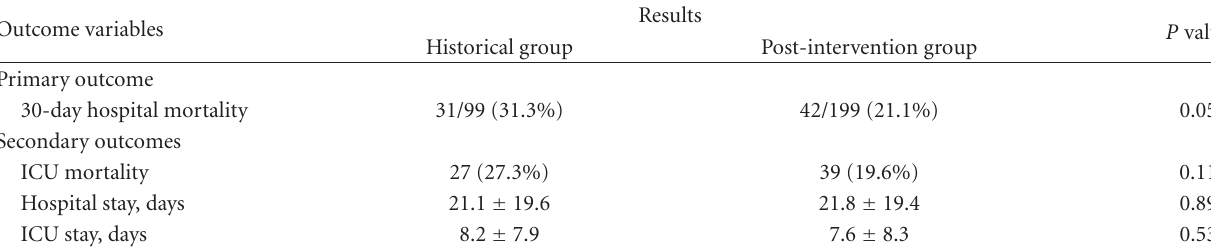
Table 4: Outcome